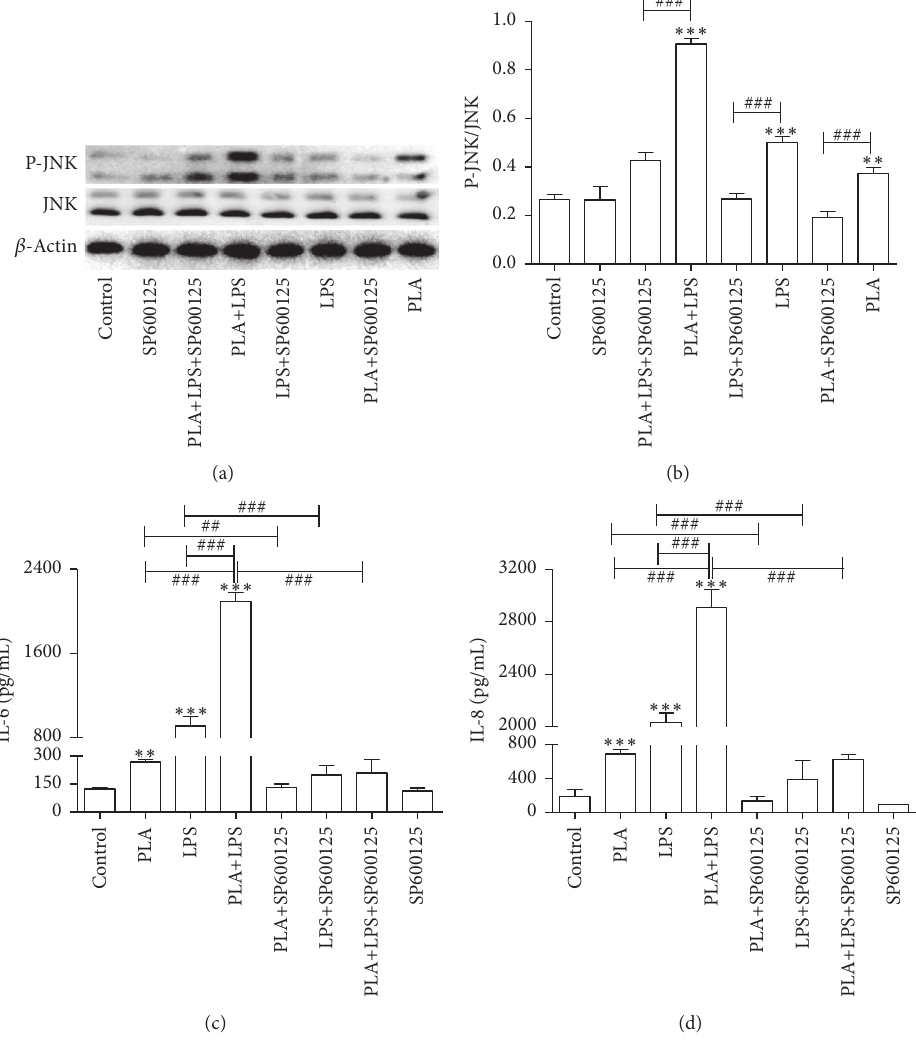
Figure 3: The JNK pathway inhibitor SP600125 alters the release of IL-6 and IL-8 by NCI-H292 cells. NCI-H292 cells were stimulated with 5 𝜇 g/mL PLA, 5 𝜇 g/mL LPS, or 5 𝜇 g/mL PLA + 5 𝜇 g/mL LPS for 60min after preincubation with SP600125. The expressions of p-JNK and JNK were measured using western blotting. 𝛽 -actin was used as an internal control. Production of IL-6 and IL-8 was measured by ELISA. ((a) and (b)) The expression level of phosphorylated JNK in NCI-H292 exposed to PLA, LPS, or PLA+LPS was inhibited effectively by the inhibitor SP600125. ((c) and (d)) PLA+LPS stimulated significantly more IL-6 and IL-8 production than either PLA or LPS treatment alone. The synergistic effects of PLA+LPS on the release of IL-6 and IL-8 could be blocked by SP600125. Significant differences are shown as follows: compared with the control group, ∗∗ 𝑃 < 0.01 , ∗∗∗ 𝑃 < 0.001 ; compared with the PLA+LPS group, ### 𝑃 < 0.001 ; PLA compared